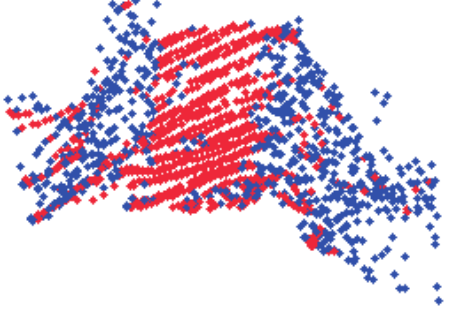
Figure 16. Application of the discrete Laplacian method for road detection. (Red ) Road surface points detected by the discrete Laplacian operator; (Blue) ALS ground